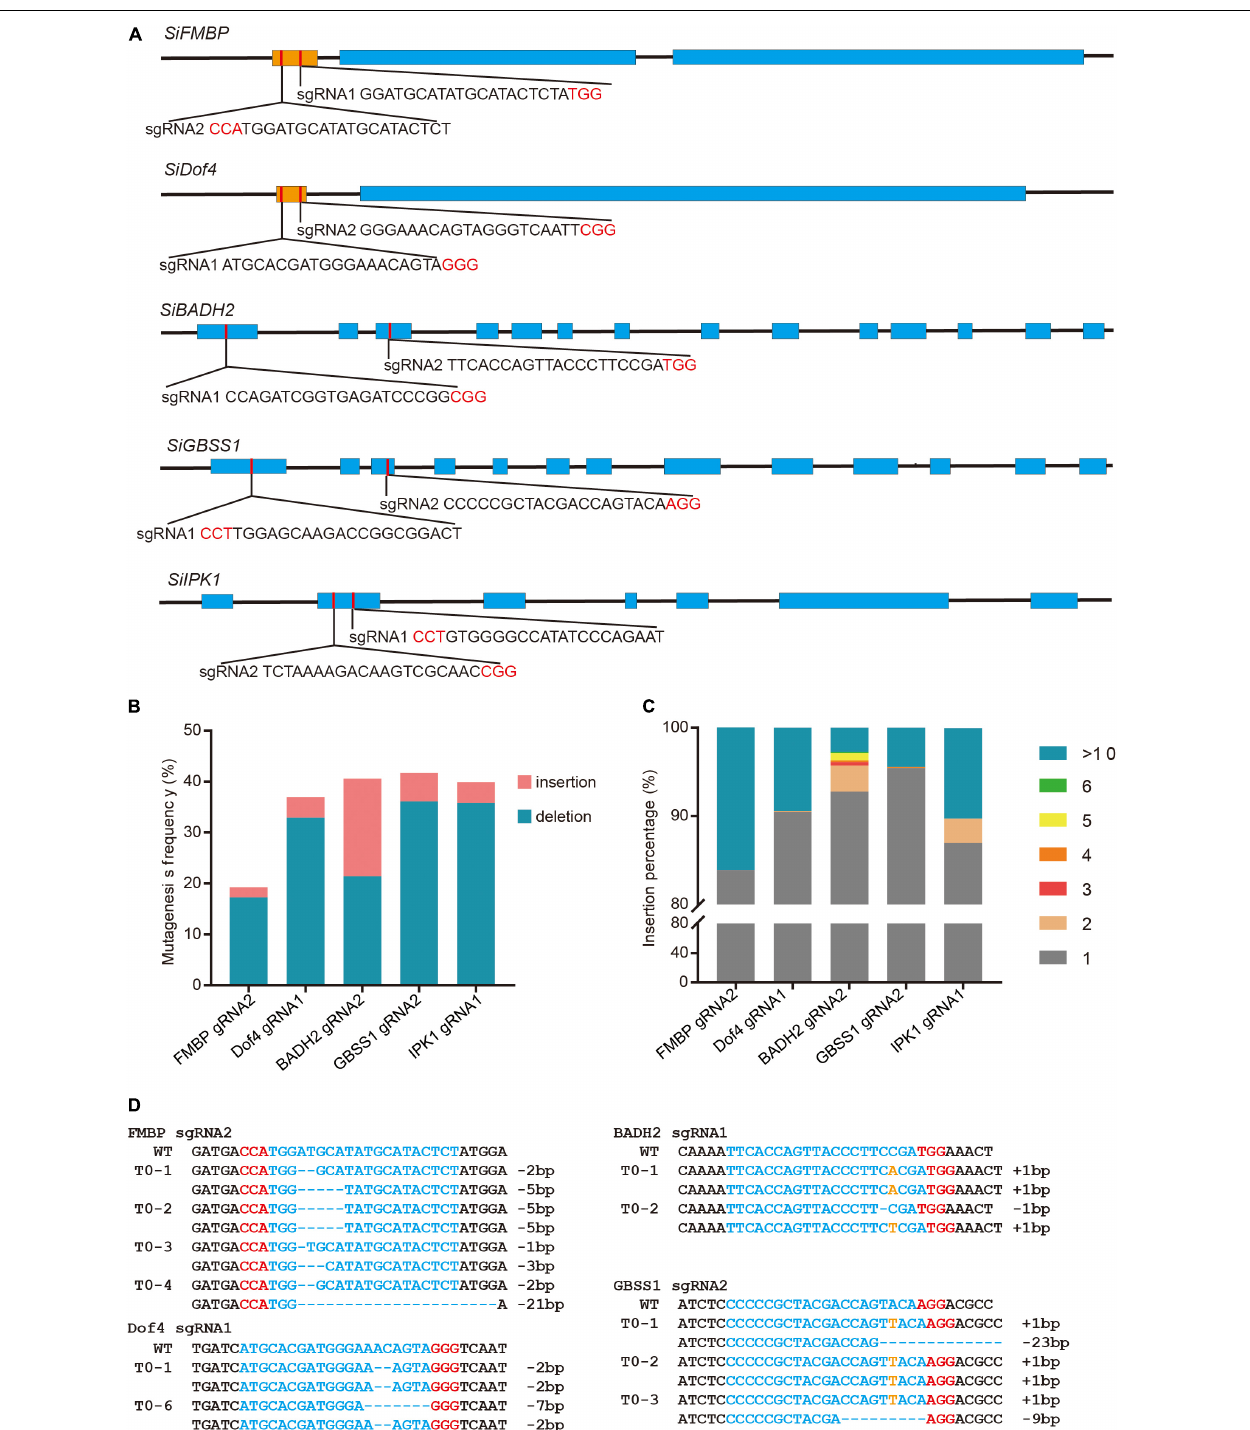
FIGURE 1 | Targeted mutagenesis in foxtail millet using the CRISPR/Cas9 system. (A) Schematic structures of the SiFMBP , SiDof4 , SiBADH2 , SiGBSS1 , and SiIPK genes. The blue and brown boxes indicated exons and uORF, respectively. Two sgRNAs were designed to target each gene. The PAM sequences were highlighted in red. (B) Mutagenesis frequencies of FMBP sgNRA2, Dof4 sgRNA1, BADH2 sgRNA2, GBSS1 sgRNA2, and IPK1 sgRNA1 in transient protoplasts assay were analyzed by next generation sequencing. (C) Percentages of insertion mutation with different lengths tested in five sgRNAs using transient protoplast assay. (D) Sanger sequence analysis of representative T 0 mutants induced by FMBP sgRNA2, Dof4 sgRNA1, BADH2 sgRNA2, and GBSS1 sgRNA2. The protospacer and protospacer-adjacent motif (PAM) sequences were highlighted in blue and red, respectively. Nucleotides inserted at the target sites were labeled orange.